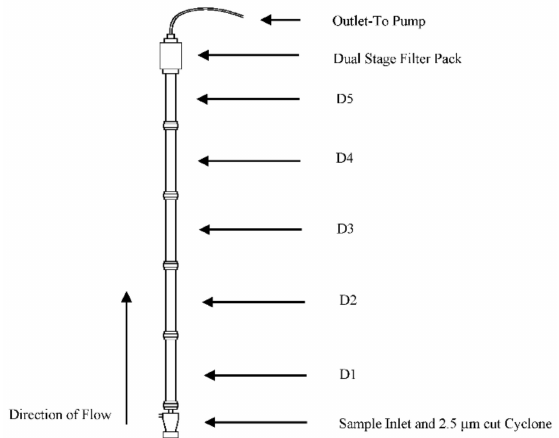
Figure 3. Five Annular Denuder System Set-Up